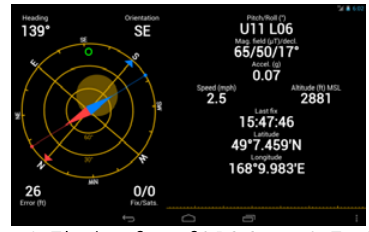
Figure 3. The interface of GPS Status & Toolbox.